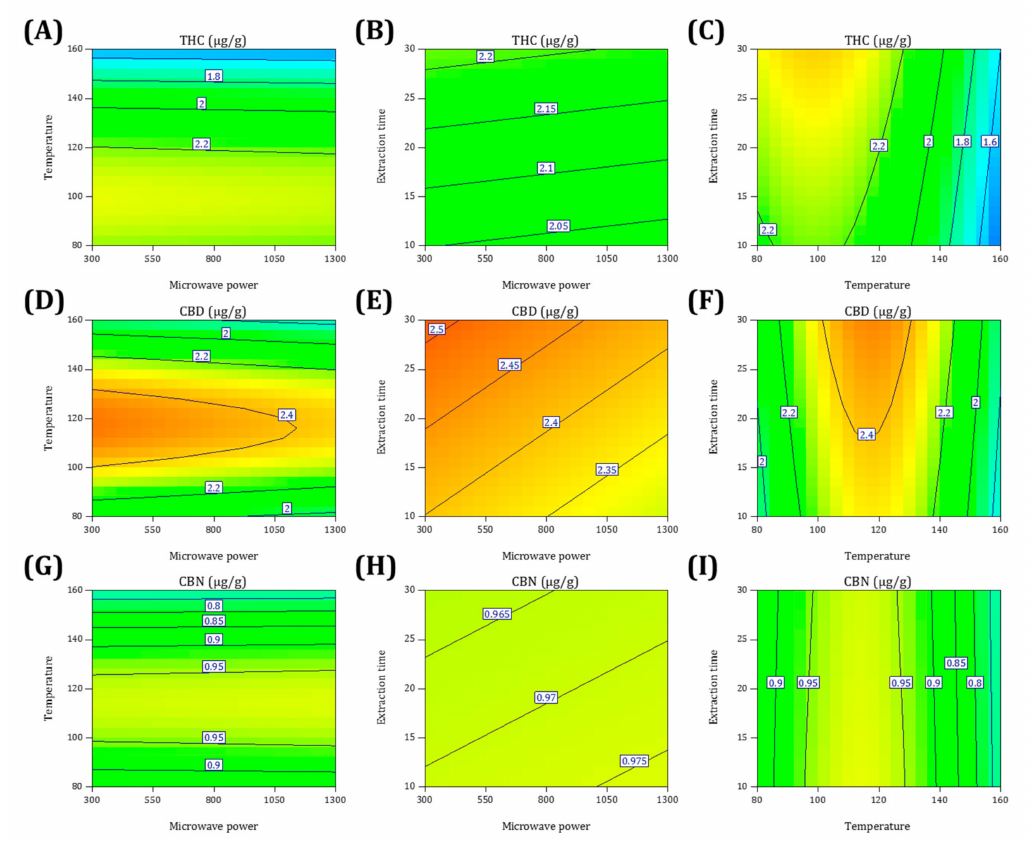
Figure 3. Contour plots showing the interaction effects of microwave power, temperature, and extraction time on the yields of THC ( A – C ), CBD ( D – F ), and CBN ( G – I